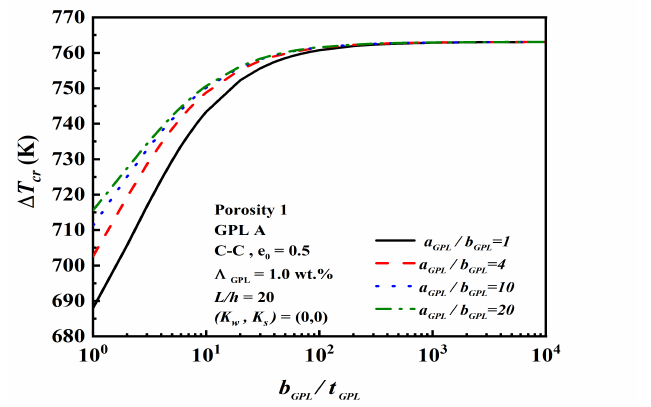
Figure 7. Effect of a GPL / b GPL and b GPL / t GPL of GPL nanofillers on the critical buckling tempera- ture